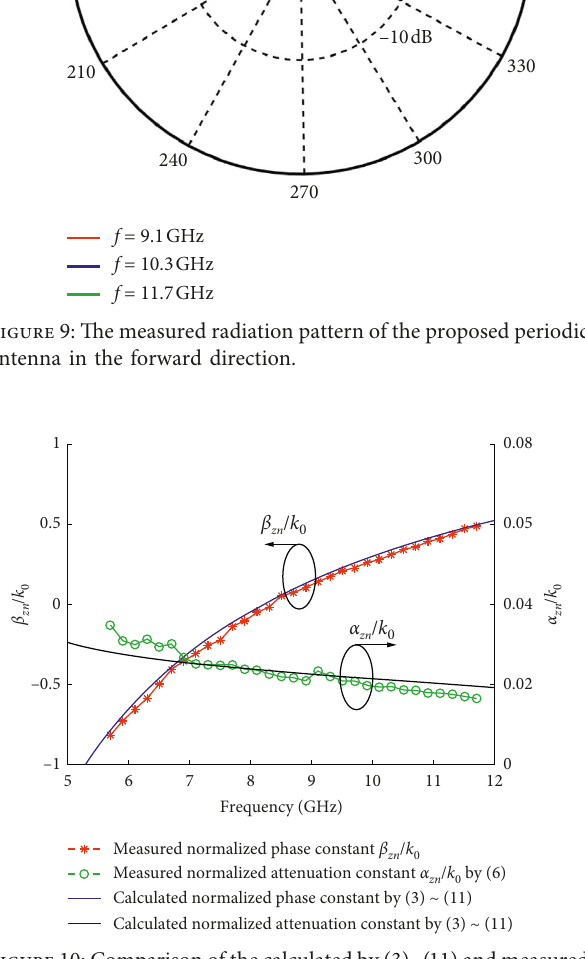
Figure 10: Comparison of the calculated by (3) ∼ (11) and measured propagation constants of the proposed